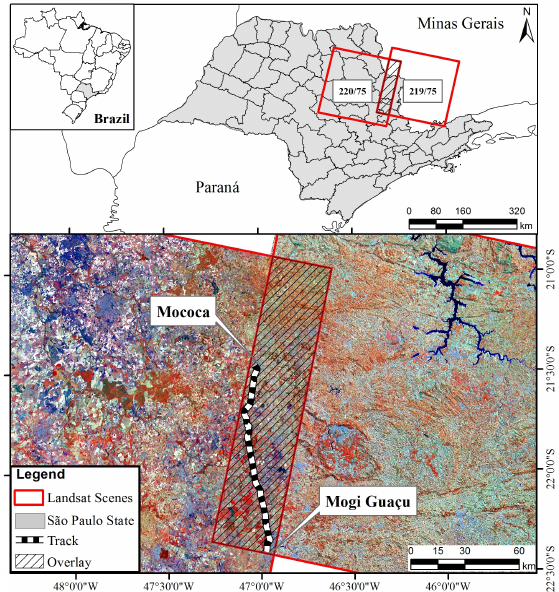
Figure 1. Study area. Map with the location of the field track (highlighted in black and white) visited